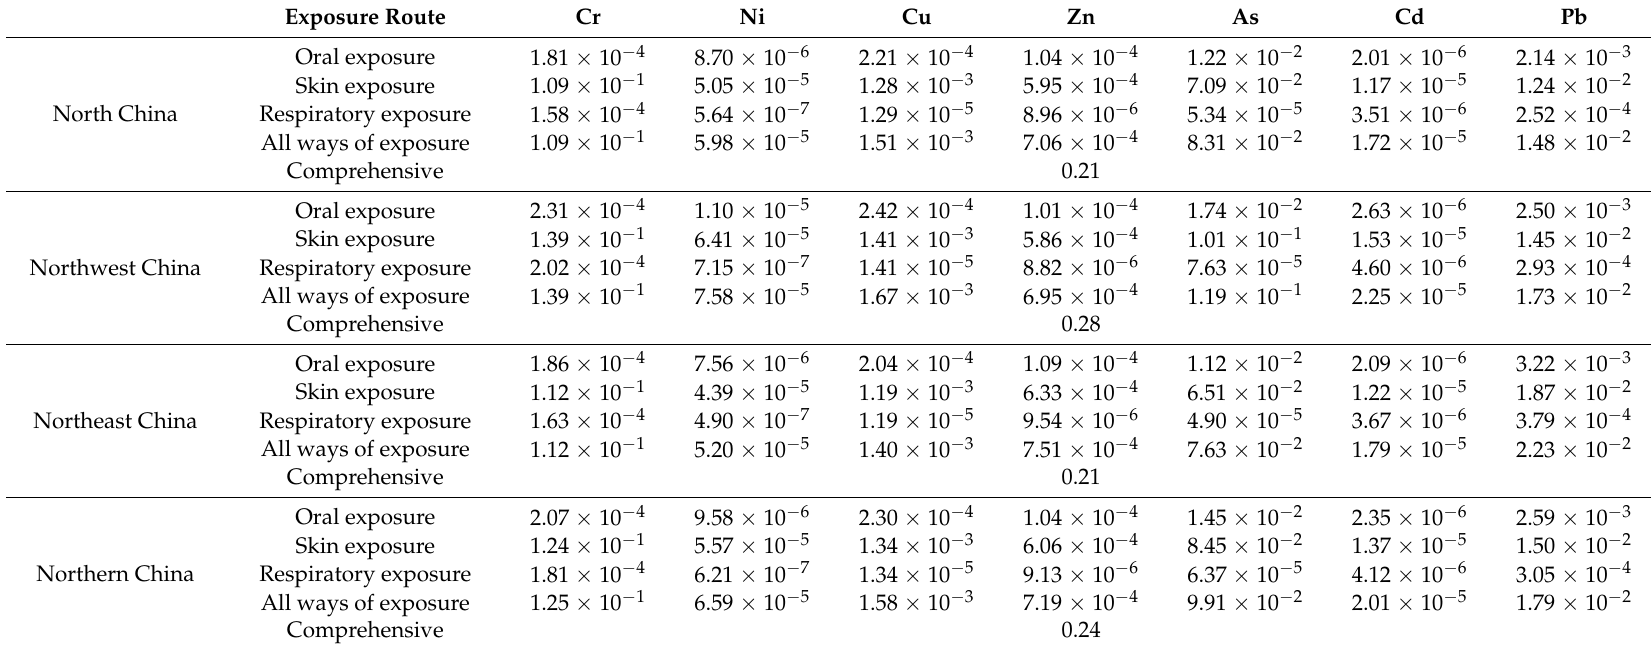
Table 8. Non-carcinogenic risk indices in the study